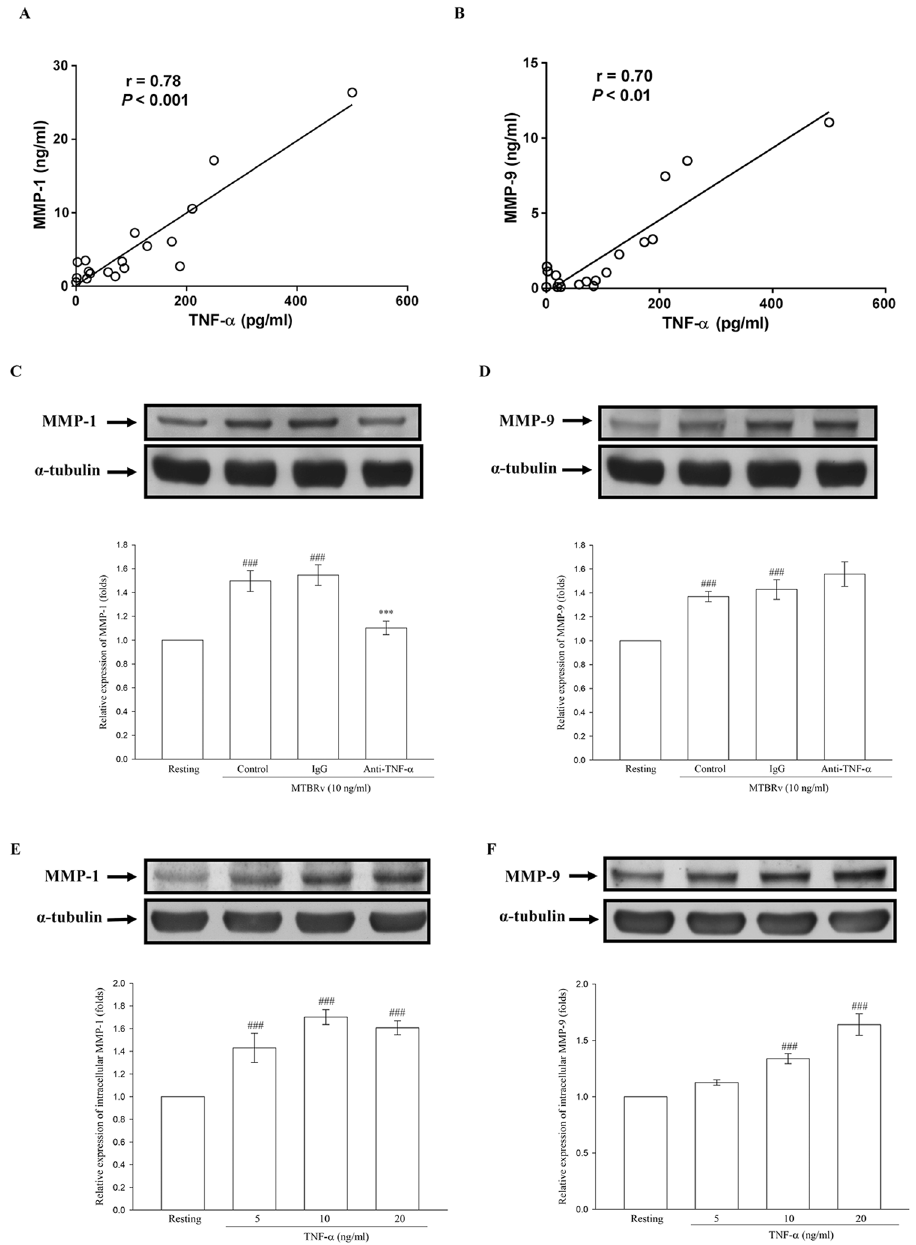
Fig 6. Relationship between pleural fluid levels of TNF- α and MMP-1/-9 in TBP. Correlation between TNF- α and (A), MMP-1 and (B), MMP-9 in TBP (n = 18). Effects of Heat-killed M. tuberculosis H37Ra or TNF- α on the expression of MMP-1 and MMP-9 in human pleural mesothelial cells. (C) and (D), MeT-5A cells were pretreated with vehicle (control), control IgG (12 μ g/ml) or anti-TNF- α Ab (12 μ g/ml) for 30 min, then stimulated with MTBRa for 24 hours. (E) and (F), MeT-5A cells were stimulated with TNF- α (5 – 20 ng/ml) for 24 h. The level of MMP-1 and MMP-9 was assessed by Western blot. Data are shown as mean ± SD of three to four independent experiments. ### p < 0.001 compared with the resting group; *** p < 0.001 compared with the MTBRa-treated group (control). TNF, tumor necrosis factor; MMP, matrix metalloproteinase; TBP, tuberculous pleuritis; MTBRa, heat-killed M . tuberculosis